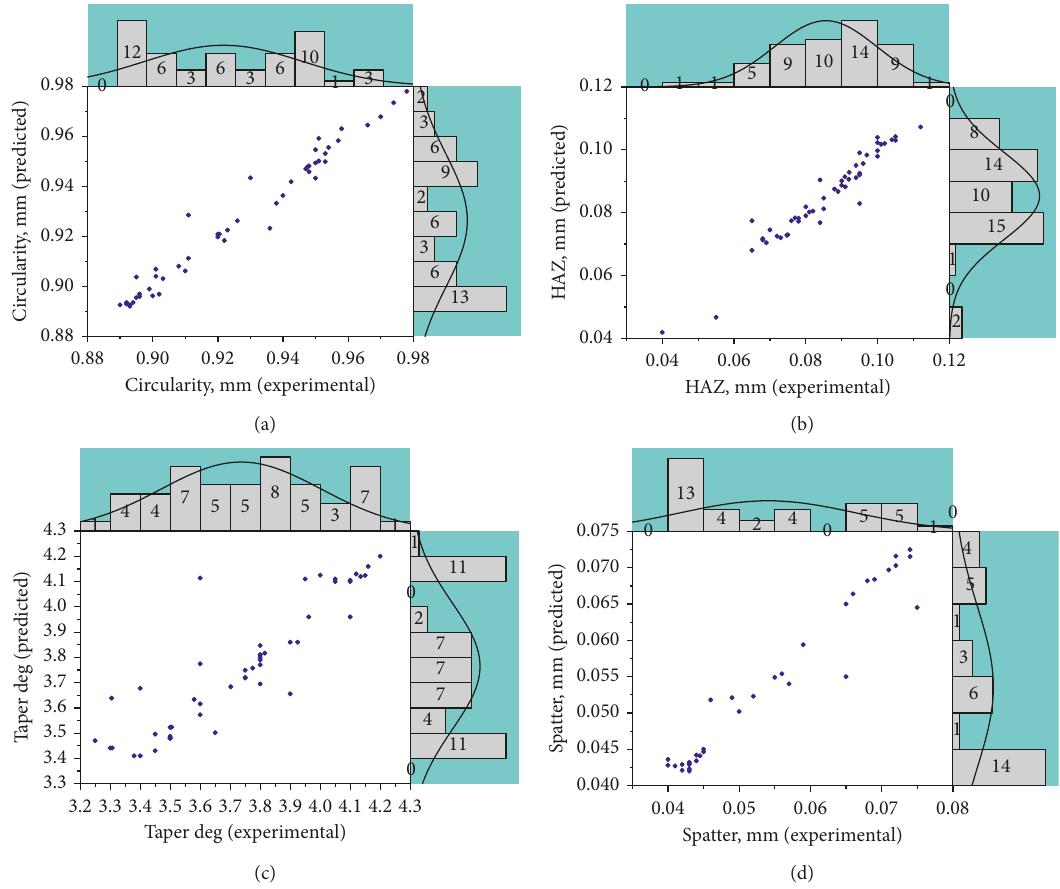
Figure 3: Experimental-predicted relationship of (a) circularity, (b) HAZ, (c) taper, and (d)